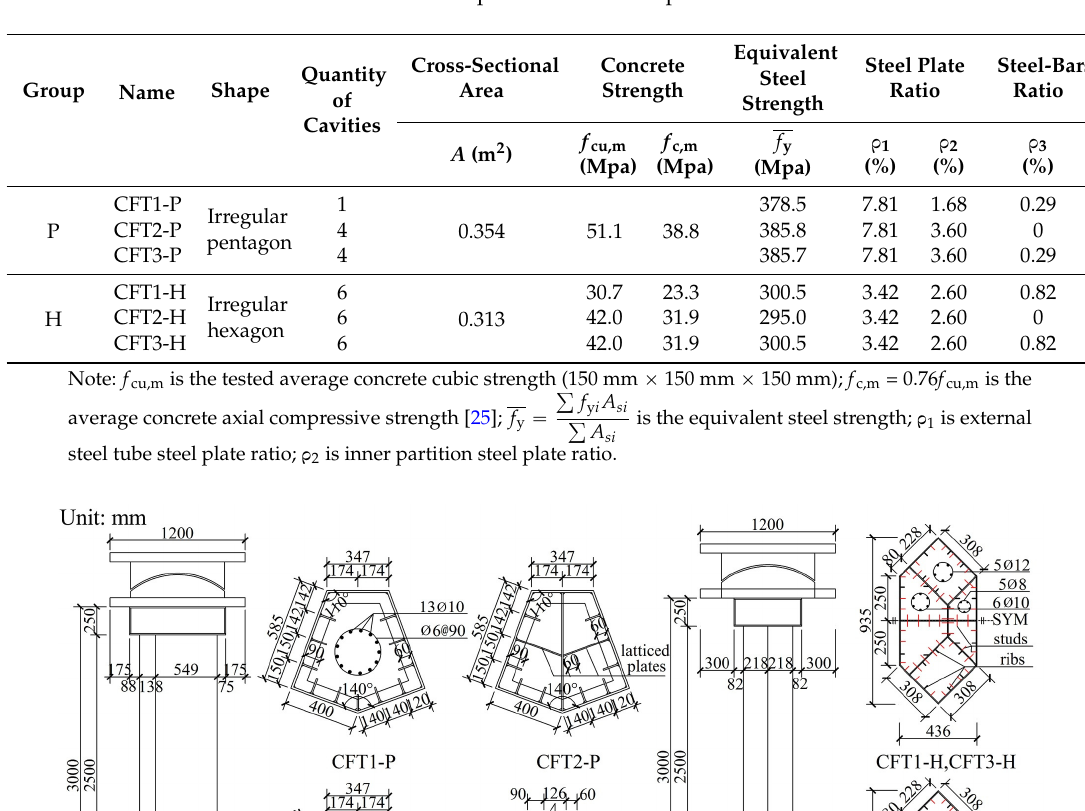
Table 1. Main parameters of the specimens.